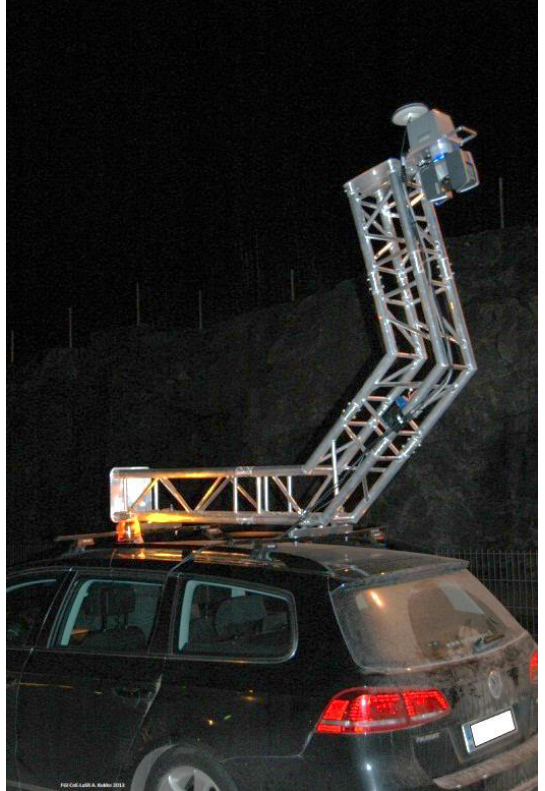
Figure 2. The Roamer R2 MLS of the FGI used for the test field measurements.